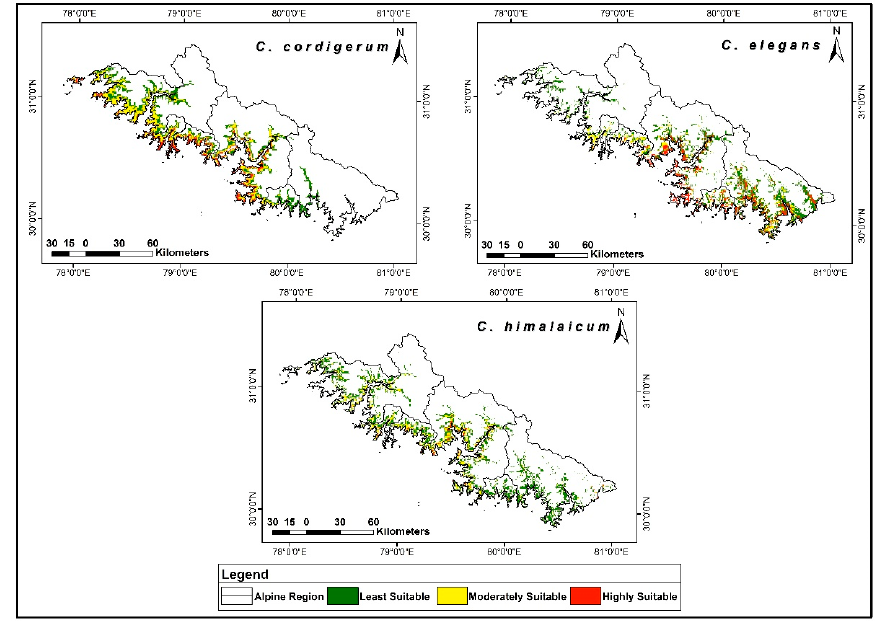
Figure 2. Current habitat suitability of C. cordigerum, C. elegans, and C. himalaicum.